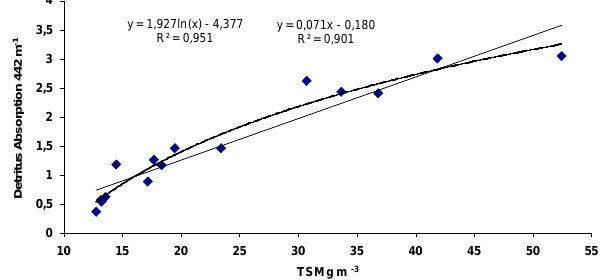
Fig. 12. Relationship between total suspended matter dry weight (TSM) and the absorption coefficient of the particulate matter at 442nm, logarithmic and linear fit.